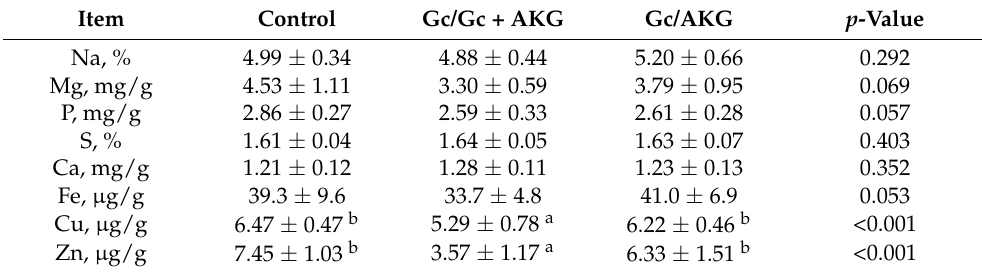
Table 3. The concentration of micro- and macro-elements in the blood serum of 35-day-old piglets. Item